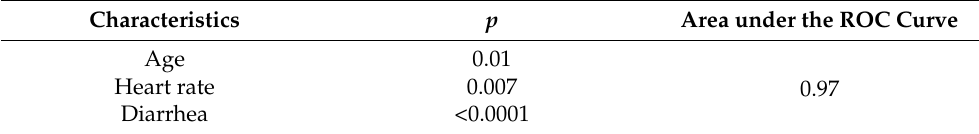
Table 3. Logistic regression based on age, heart rate, and